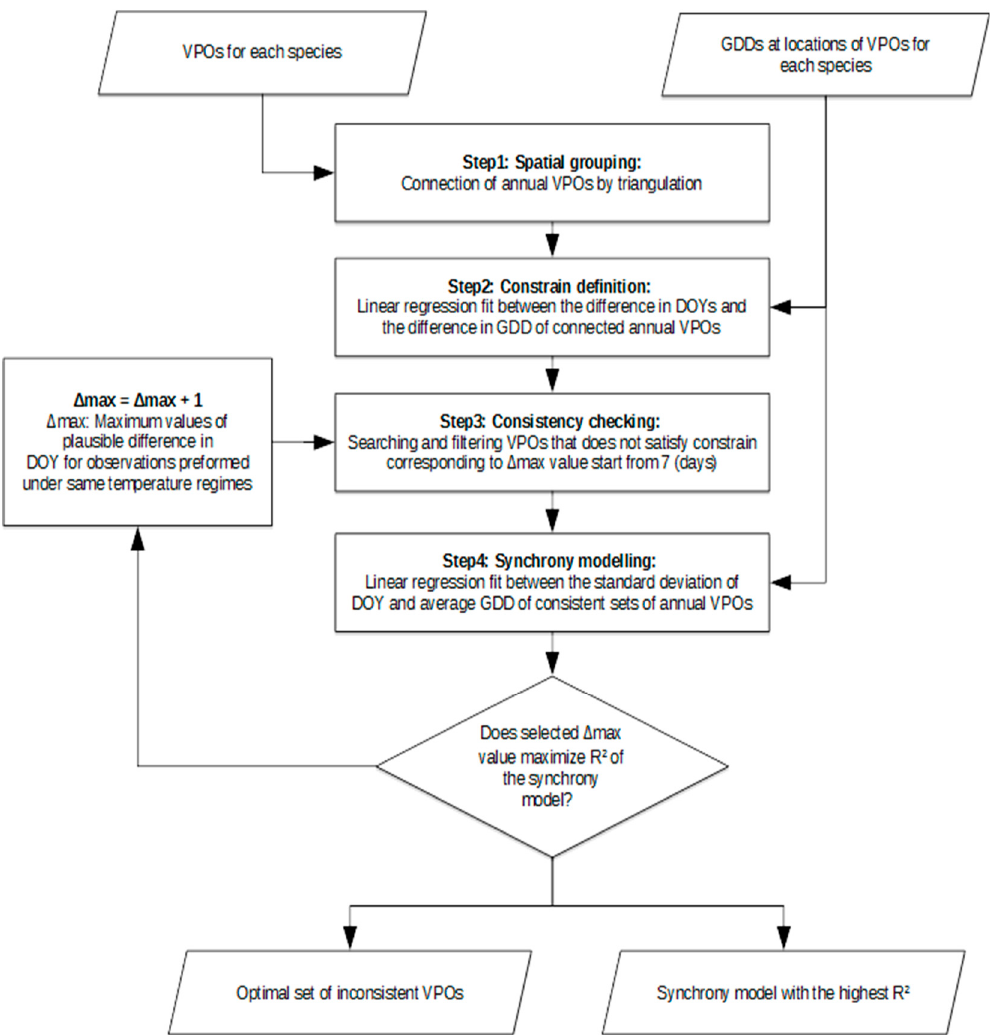
Figure 1. Flowchart of the proposed workflow that uses the coordinates of the volunteered phenological observations, their observed date and the GDDs accumulated until that date to check their consistency and to model phenological synchrony.